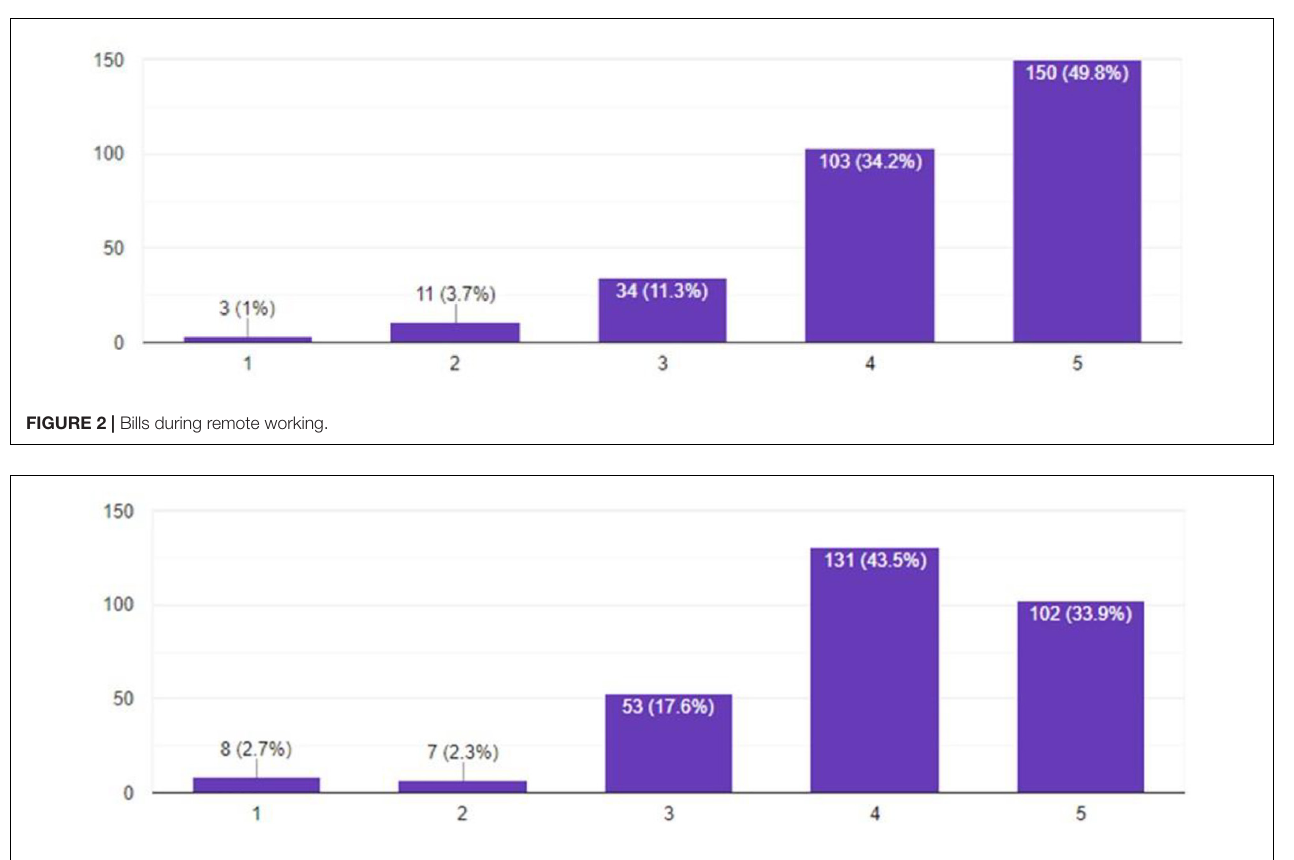
FIGURE 3 | Bills during on-site